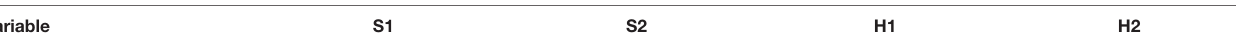
Frontiers in Marine Science |